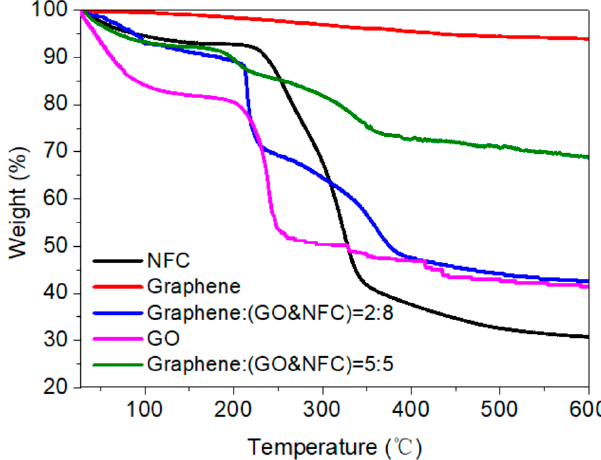
Figure 17. Thermogravimetric analysis (TGA) results for the graphene, NFC, GO, and composite membranes.